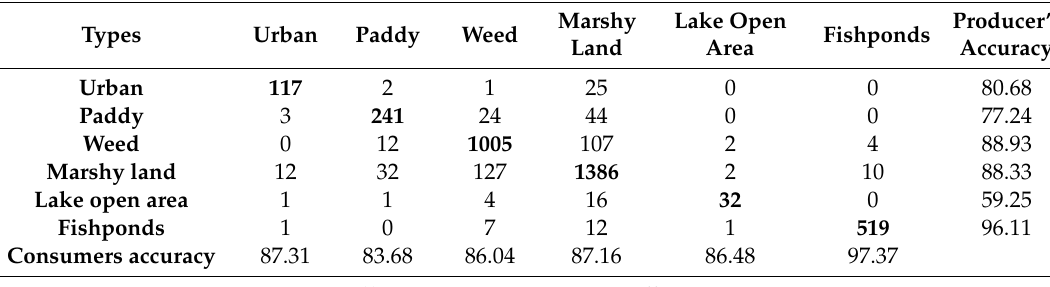
Overall accuracy: 88%, Kappa coe ffi cient: